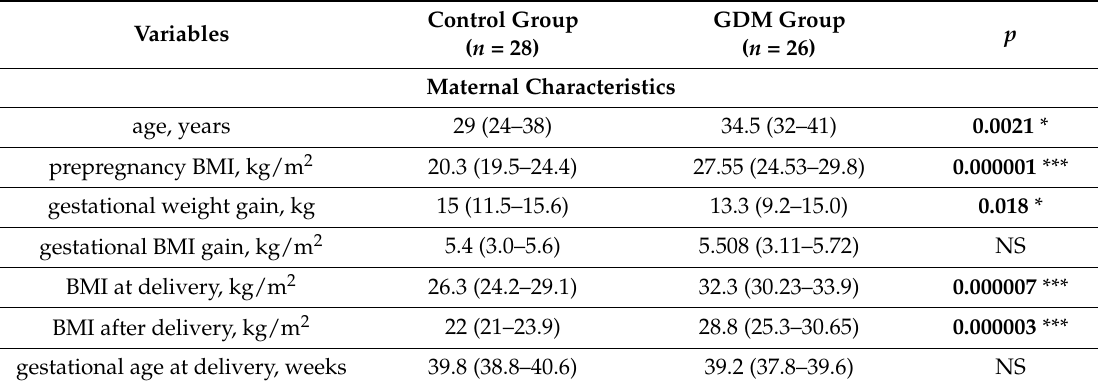
Table 1. Comparison of characteristics of the study